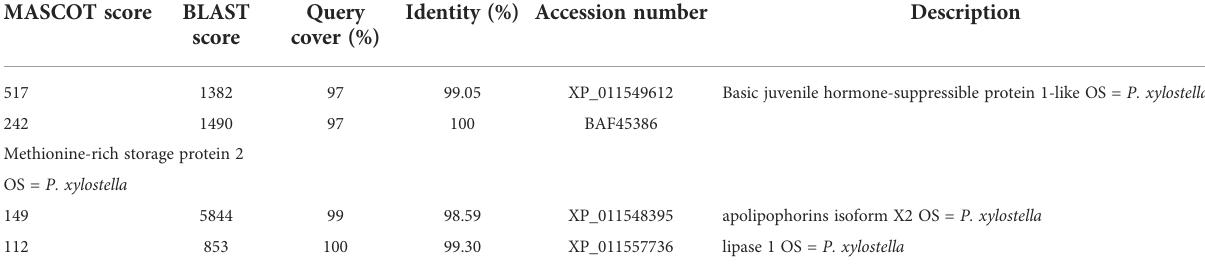
TABLE 2 Cry7Ab4-binding proteins in the midgut juice of P. xylostella larvae. MASCOT score BLAST Query score cover (%)